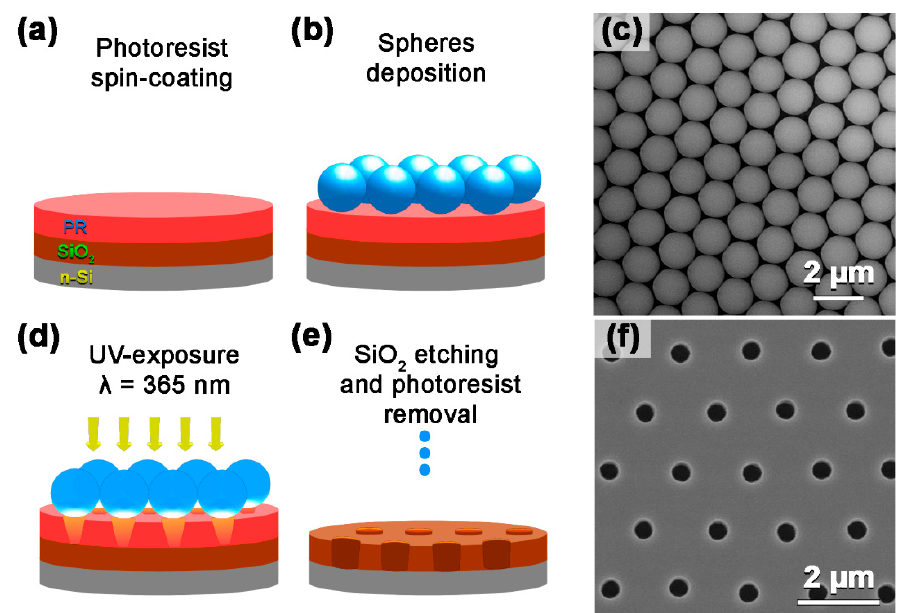
Figure 1. Workflow of Si/SiO 2 substrate patterning: ( a ) spin-coating of the photoresist, ( b ) micro- sphere deposition, ( d ) UV exposure of the photoresist through a monolayer of microspheres, ( e ) SiO 2 layer etching through the patterned photoresist. SEM images of the arrays of microspheres deposited on the photoresist layer ( c ) and microholes in the SiO 2 mask on the Si substrate ( f ).